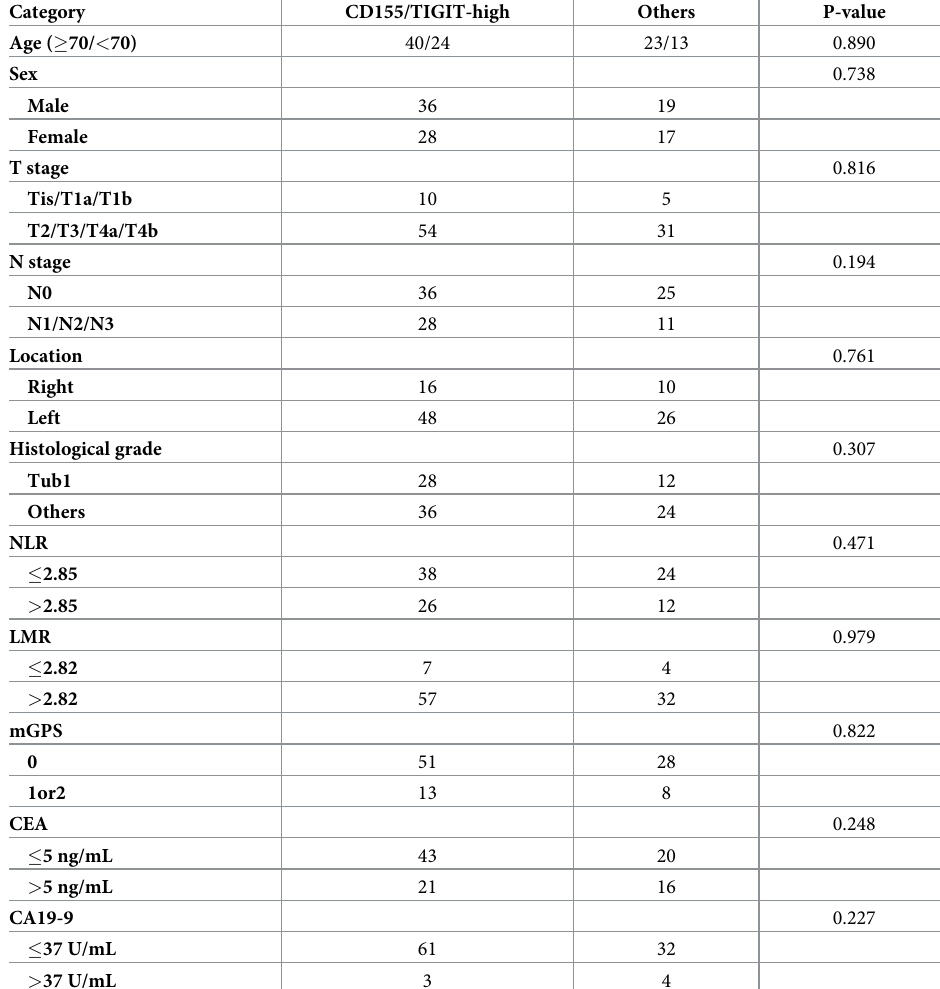
Table 3. Patient background and CD155/TGIT